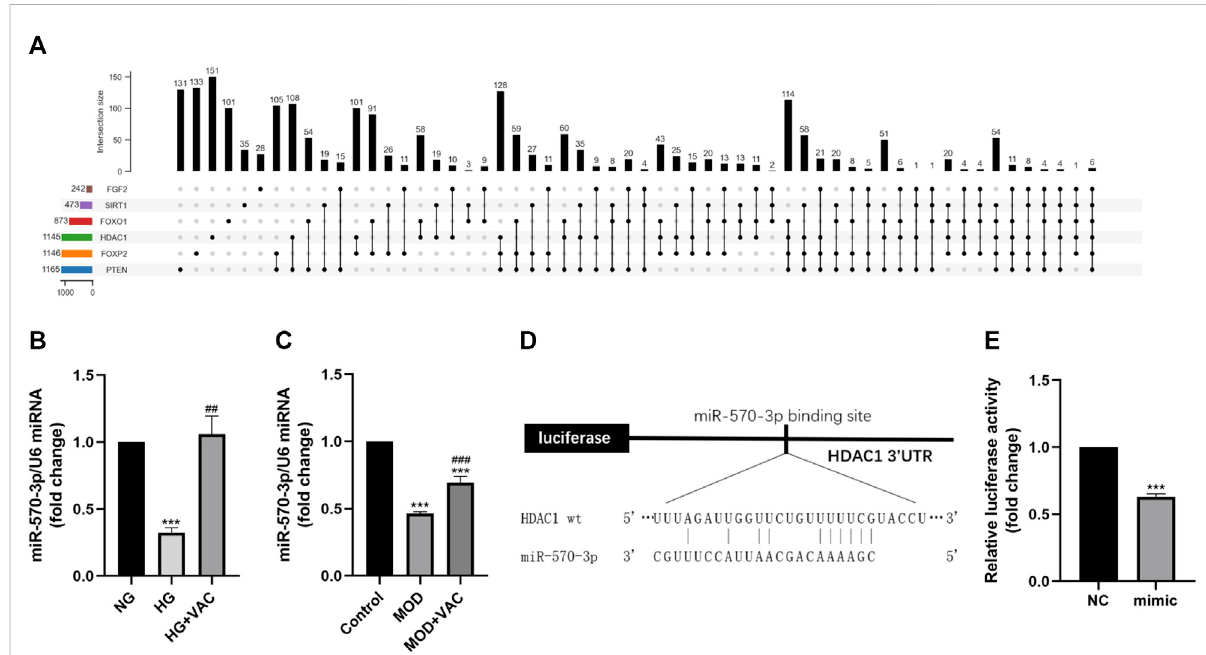
FIGURE 6 Vaccarin inhibited the HG-induced decrease of miR-570-3p in vitro . (A) . Upset graph is used to represent overlapping sets of elements for miRNAs. (B – C) . The effects of vaccarin on the expression of miR-570-3p miRNA in HG-induced HUVEC cells and aortic tissue. (D) . Complementary bases between miR-570-3p and the 3 ′ UTR ofHDAC1. (E) . Luciferaseactivitywas detected inthe HUVEC cells. Values aremean ± SEM. n= 3in each group. * p < 0.05, ** p < 0.01, *** p < 0.001 vs. NG or Control; # p < 0.05, ## p < 0.01, ### p < 0.001 vs. HG or